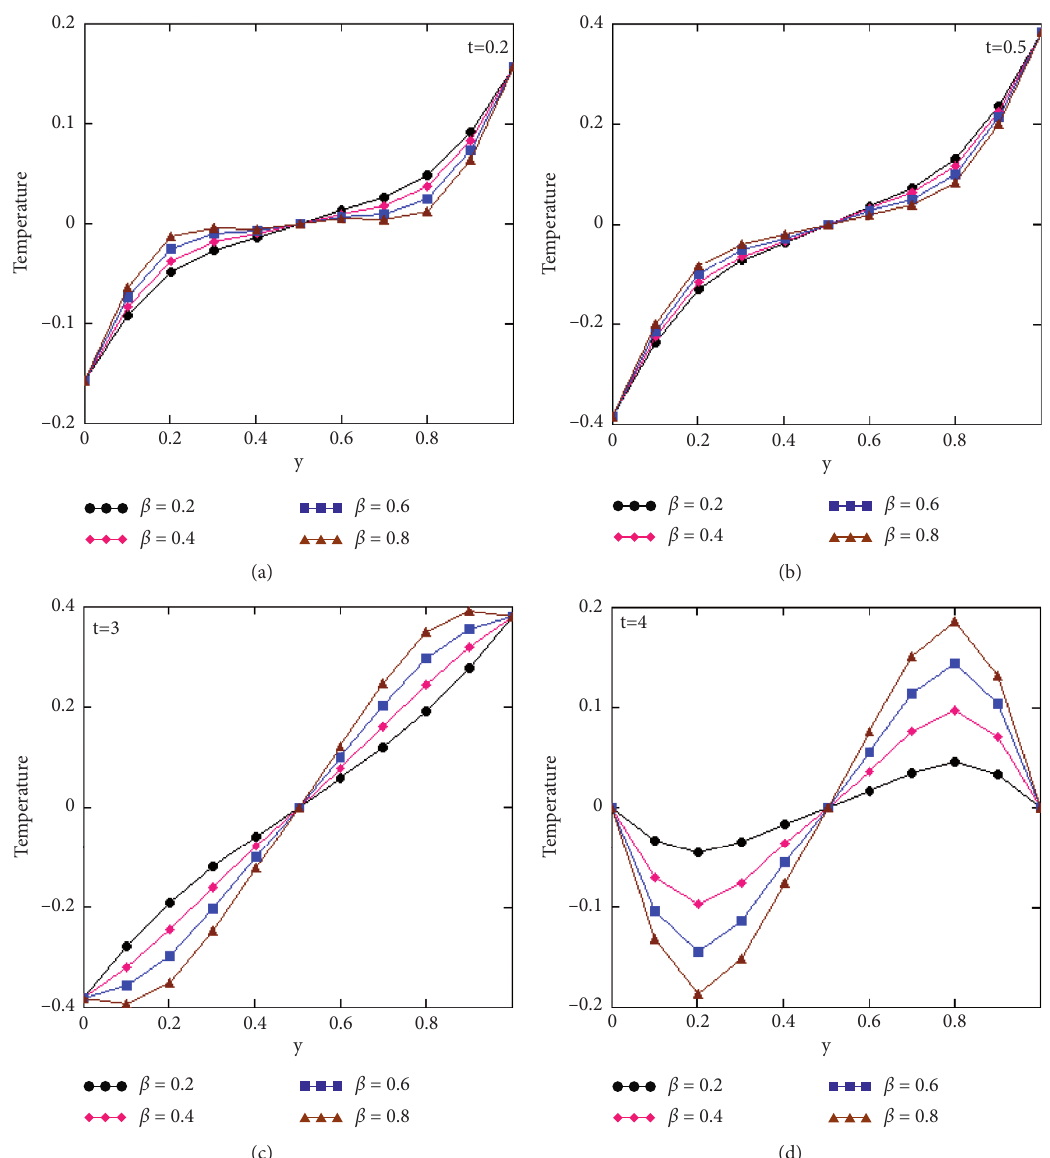
Figure 2: Profiles of dimensionless temperature versus y for variation of β at altered values of time t , Pr � 20and Q � 0 . 5, and ( t ) � − sin ( π t /4 ) and f ( t ) � sin ( π t /4 ) f 1 2